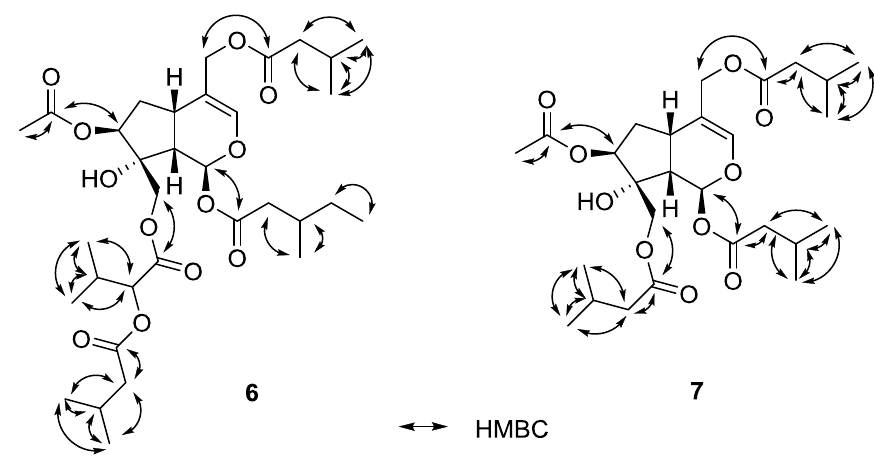
Figure 5. Key HMBC correlations of valtrates 6 and 7 .